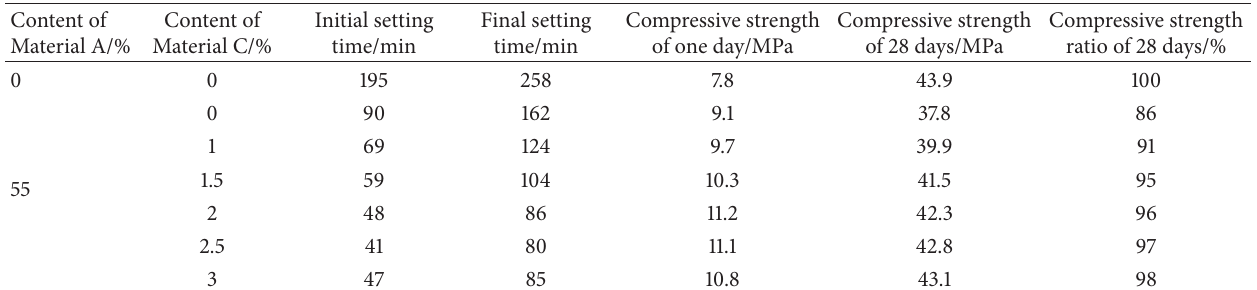
Table 8: Experimental results of combination of Materials A and C.